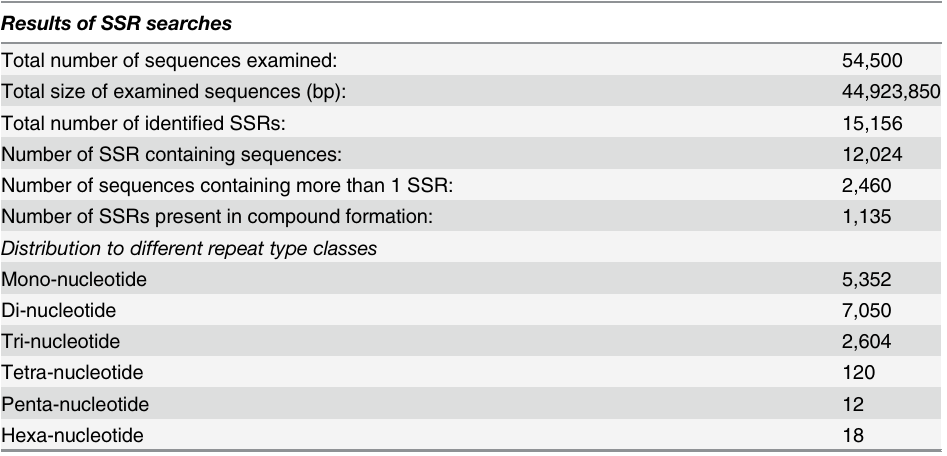
Table 2. Statistics of SSRs detected in red perilla. Results of SSR